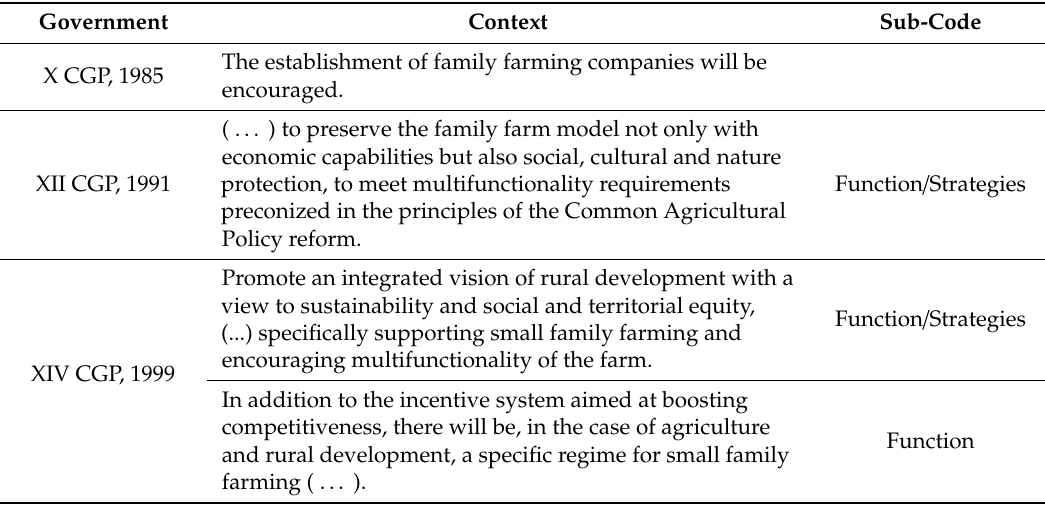
Table 3. Conceptual references to family farming in the Portuguese Government programs.